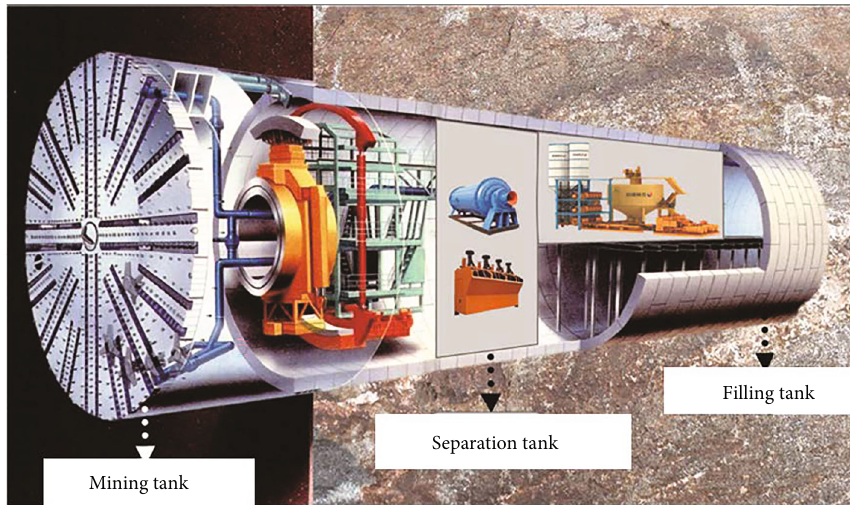
Figure 4: In situ fl uidization mining process [39].